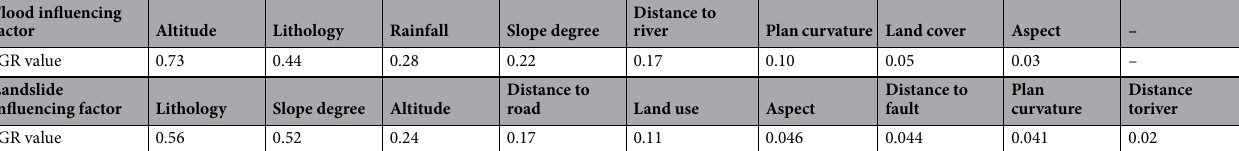
Table 2. Importance of natural hazards influencing factors using the information gain ratio (IGR)